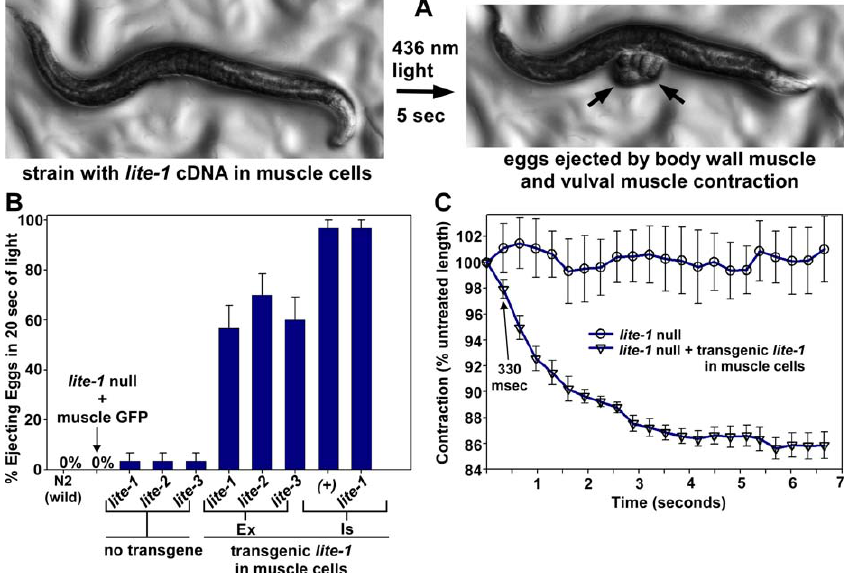
Figure 10. LITE-1 Is Sufficient to Confer Light Responsiveness to Muscle Cells (A) Blue-violet light-induced contraction of body wall muscles forces egg ejection in transgenic animals expressing the lite-1 cDNA in body wall muscle. Genotype of the strain is lite-1(ce314); ceIs37 ( myo-3::lite-1 cDNA). (B) Shown are the percent of animals that ejected eggs during a 20-s stimulus of 436 nm light. Note that the LITE-1 – induced muscle contraction does not require LITE-2 or (cid:2) 3. Genotypes of transgenic strains from left to right: lite-1(ce314); ceEx190 ( myo-3:: GFP), lite-1(ce314); ceEx186 ( myo-3::lite-1 cDNA), lite-2(ce311); ceEx189 ( myo-3::lite-1 cDNA), lite-3(ce360); ceEx188 ( myo-3::lite-1 cDNA), ceIs37 ( myo-3::lite-1 cDNA), lite-1(ce314); ceIs37 ( myo-3::lite-1 cDNA). ‘‘ Ex ’’ and ‘‘ Is ’’ denote transgenic strains with extrachromosomal and integrated arrays. Error bars are the standard errors in populations of 30 animals. (C) Time course of LITE-1-mediated muscle contraction. Genotypes are lite-1(ce314) and lite-1(ce314); ceIs37 ( myo-3::lite-1 cDNA). Data represent the mean and standard errors of five animals